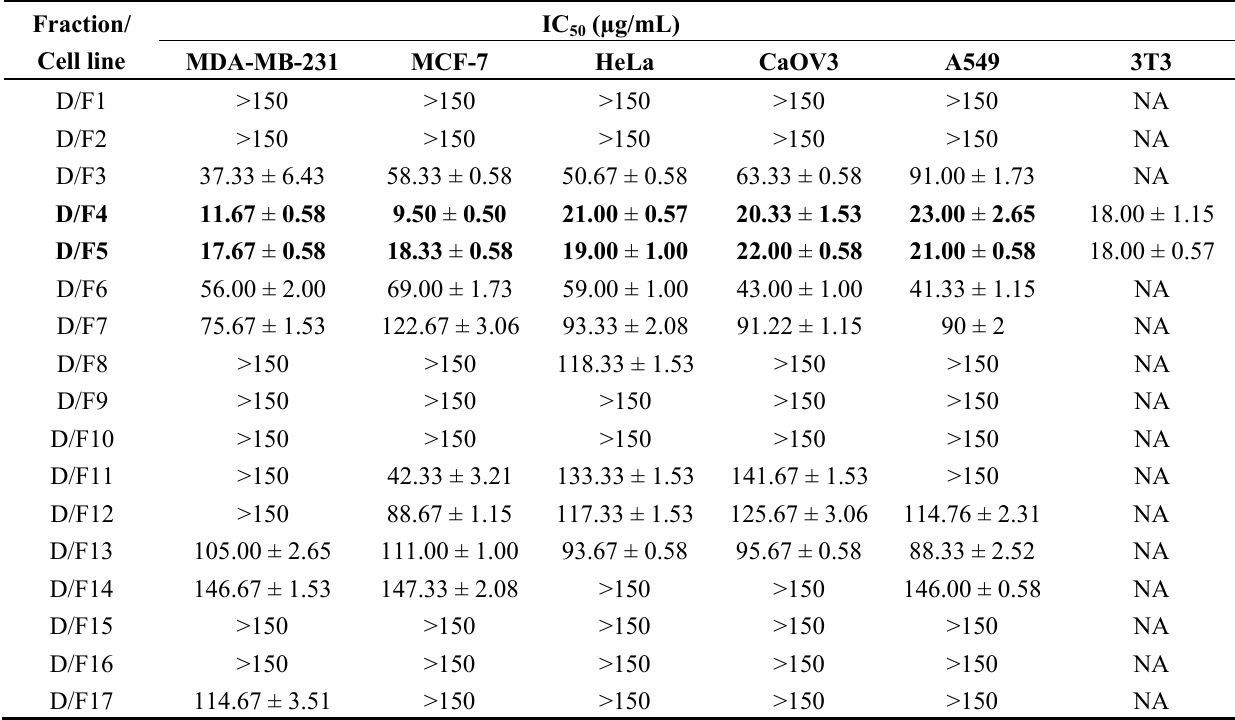
Table 3. Cytotoxicity of DCM fractions of D. suffruticosa on selected cancer and non-tumorigenic cell